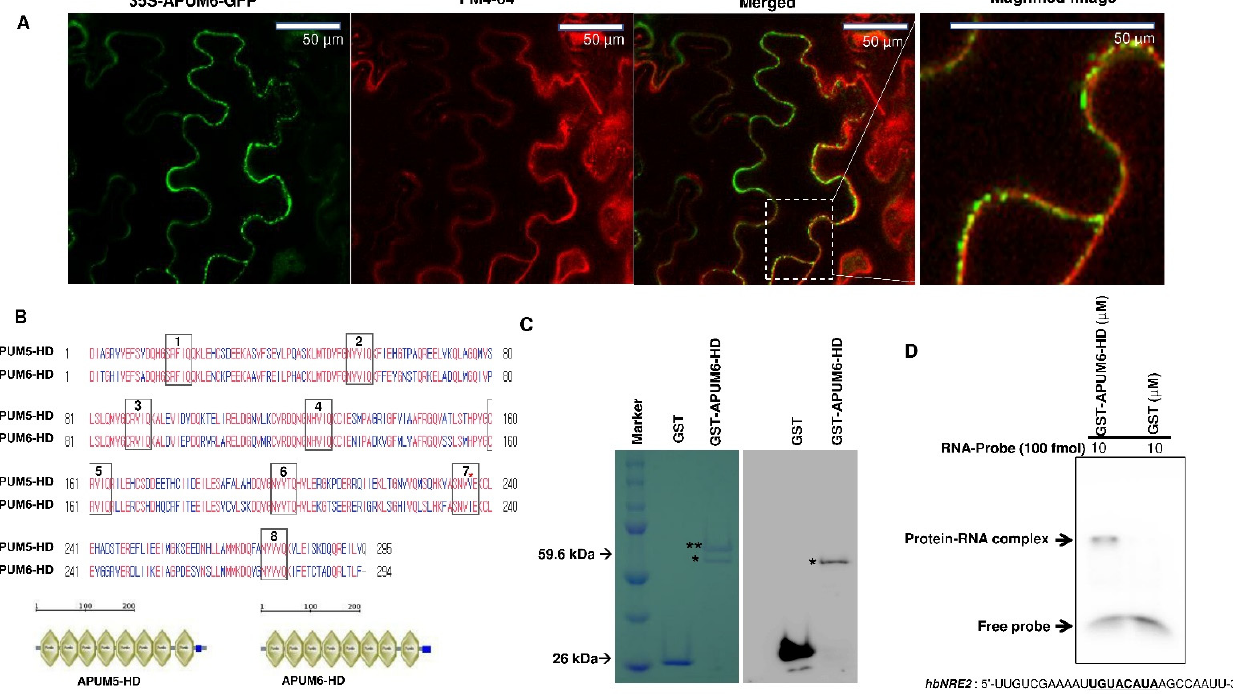
Figure 2. APUM6 localization of in planta and in vitro RNA-binding activity. ( A ) Cytosol, plasma membrane, and foci localization of APUM6-GFP. 35S::APUM6-GFP was transiently expressed in N. benthamiana leaf cells. After 3 days, the leaf was stained with FM4-64. GFP and FM4-64 signals were detected by LSM 700 confocal microscopy. Membranes were stained with FM4-64 (red signal). The resulting fluorescence images were merged (right). Scale bar = 50 µm. ( B ) Schematic representation of the APUM5 and APUM6 pumilio RNA-binding homolog domain for GST fusion. RNA-binding amino acid regions are conserved compared with APUM5. ( C ) Purified GST and GST-APUM6-HD proteins were tested using Western blot with GST antibody. Non-specific band is indicated by two asterisks, and specific band is indicated by one asterisk. ( D ) Purified GST-APUM6-HD protein has hbNRE2 RNA-binding activity. GST is used as a negative control of hbNRE2